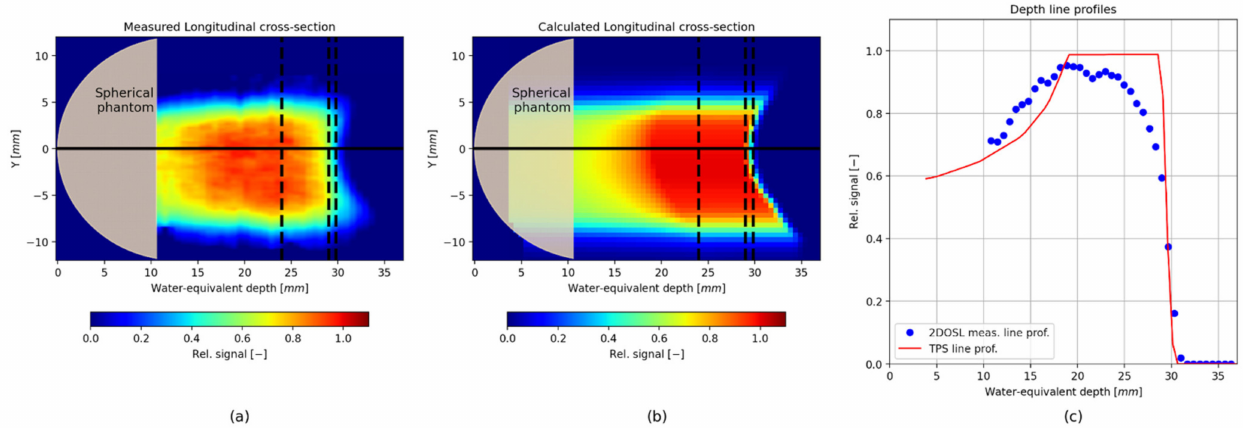
Figure 11. ( a ) The reconstructed from the 3D dose distributions longitudinal cross-section through the image centre extracted from the stack of forty 2D LMP foils, ( b ) 3D relative dose image calculated by the TPS, ( c ) A comparison of longitudinal line profiles plotted through the image centre (black solid lines visible on both 3D images).